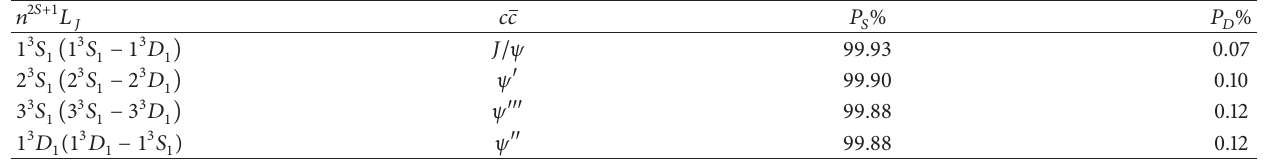
Table 3: Percent of each partial wave in mixed charmonium states.